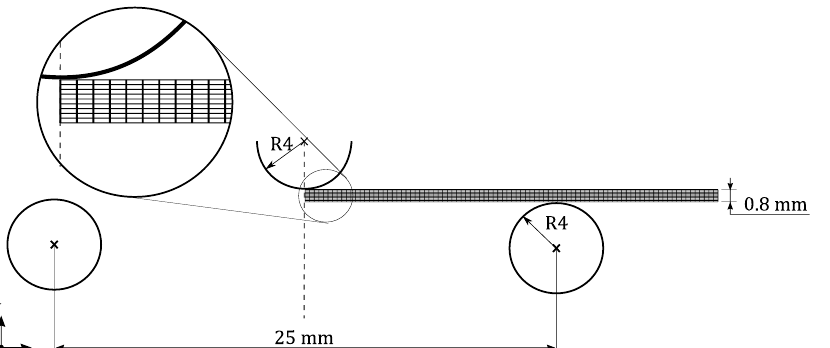
Figure 9. Three-point bending test geometry and variables defined for problem (a) FE model.